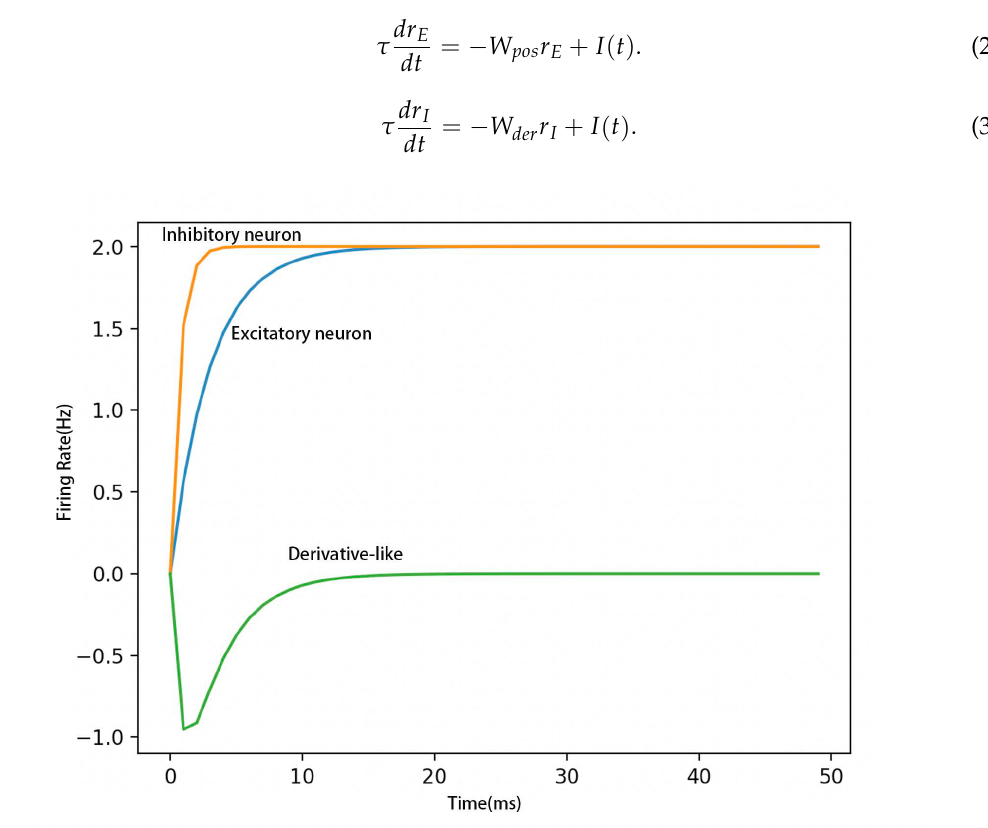
Figure 2. Firing rate experiment of negative-derivative